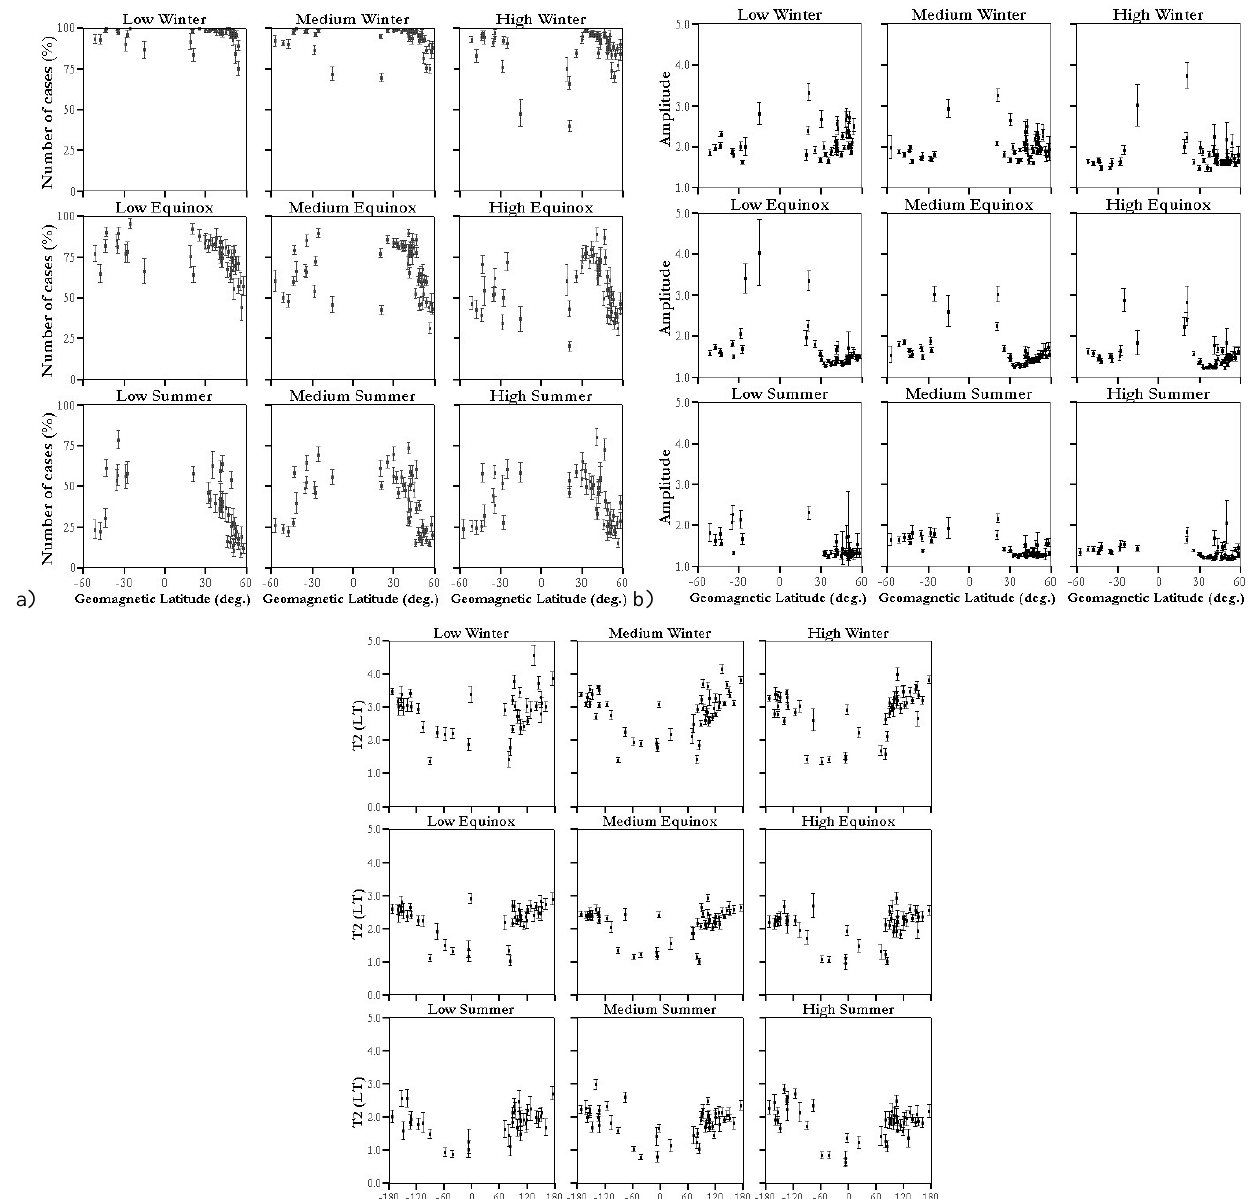
Fig. 5. (a)–(c) Same as Fig. 4 for the second peak.